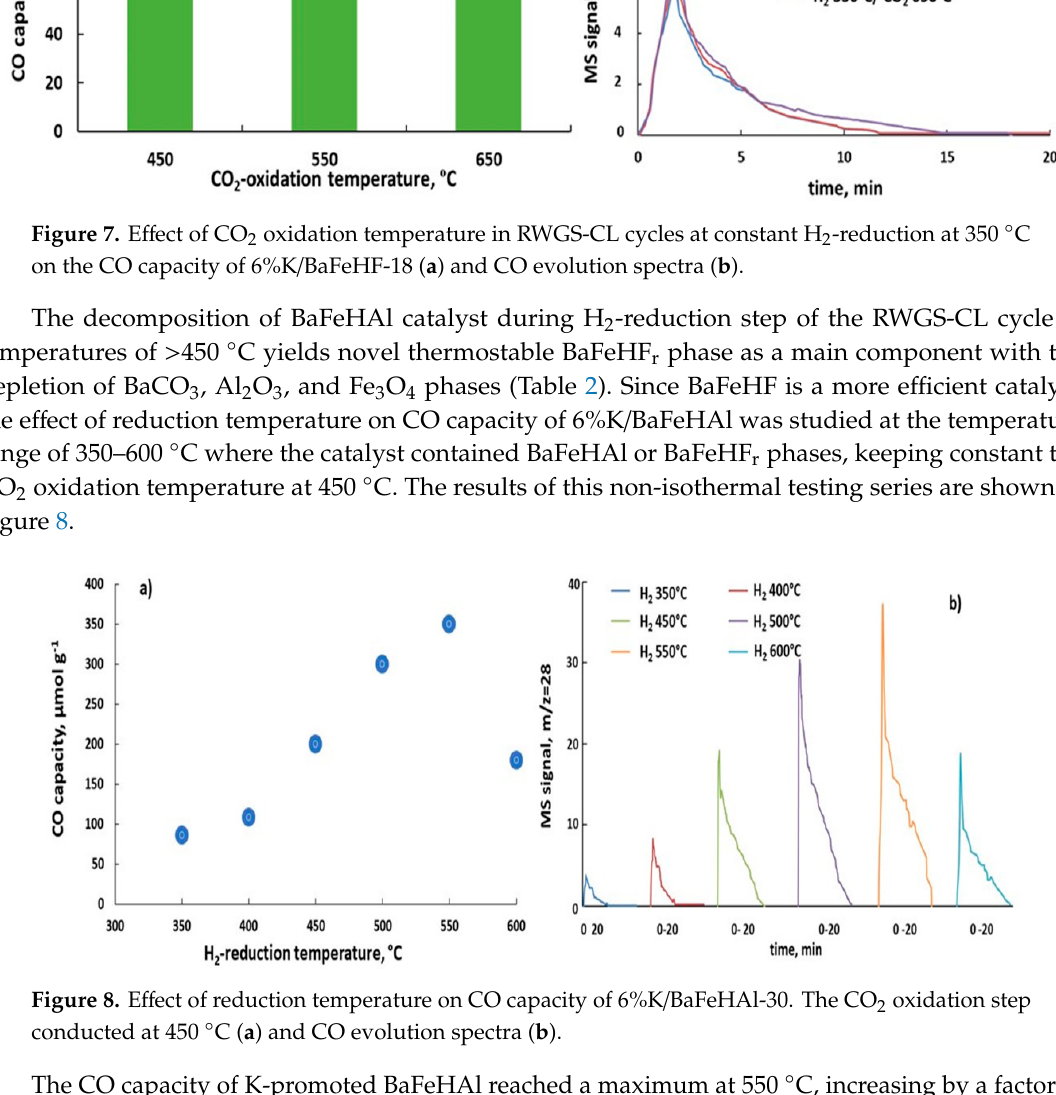
Figure 8. E ff ect of reduction temperature on CO capacity of 6%K / BaFeHAl-30. The CO 2 oxidation step Figure 8. Effect of reduction temperature on CO capacity of 6%K/BaFeHAl-30. The CO 2 oxidation step conducted at 450 ◦ C ( a ) and CO evolution spectra ( b conducted at 450 °C ( a ) and CO evolution spectra ( b ).